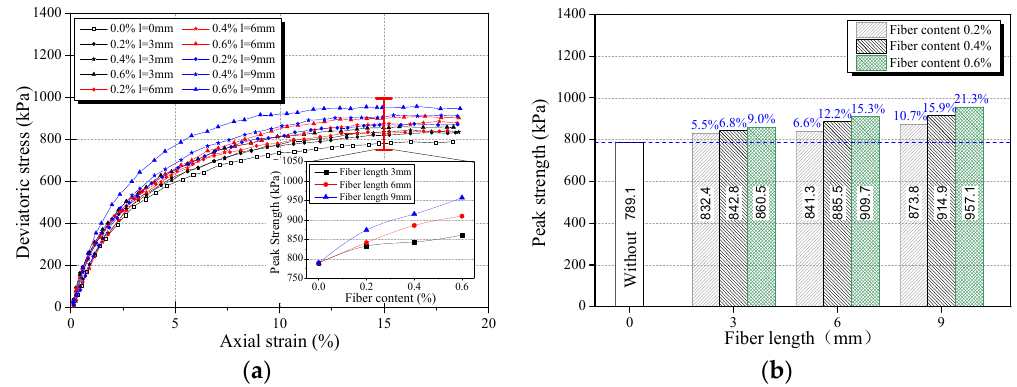
Figure 7. Stress strain curve and peak strength of fiber-reinforced tailings silt ( ρ d = 1.60 g·cm − 3 ). ( a ) Stress-strain curve, ( b ) peak strength increment of BFRT.